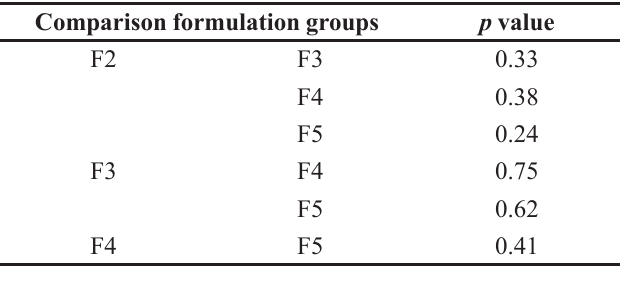
TABLE IV - Comparison of the p values from the permeation rates in four formulation groups